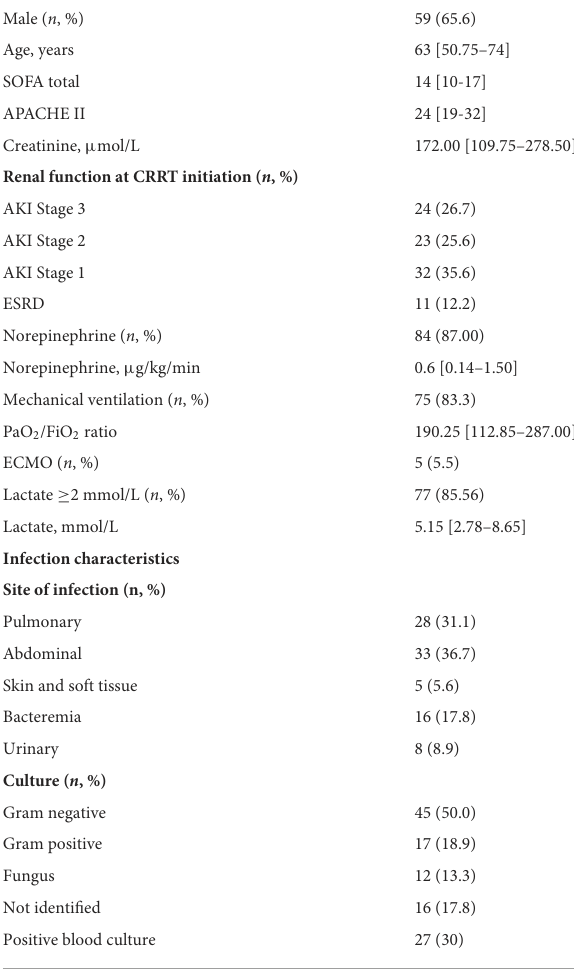
TABLE 1 Baseline characteristics and infection and clinical outcomes of included patients. Clinical